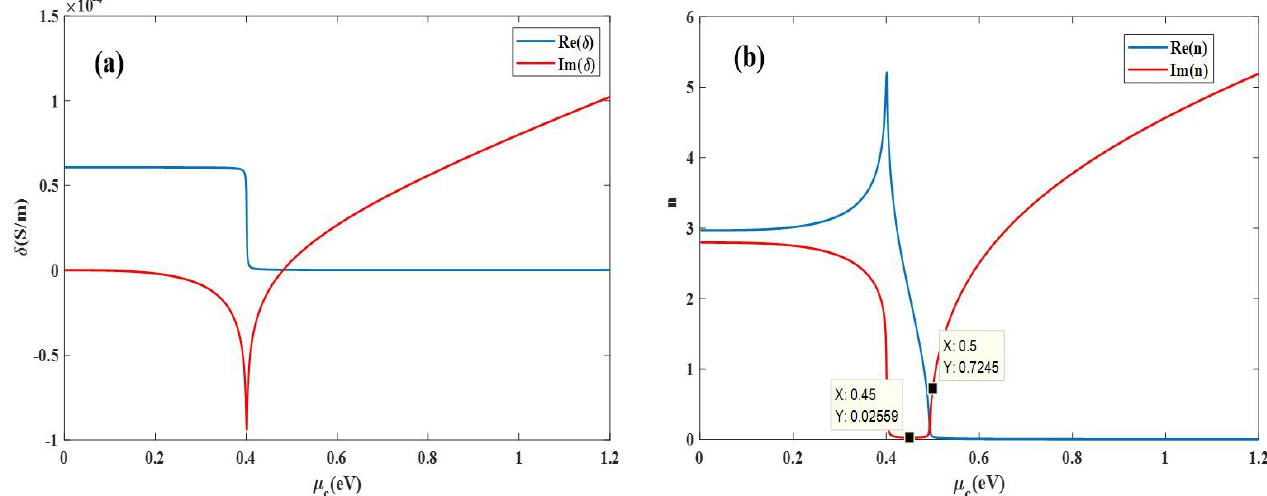
Figure 2. The graph of the electrical conductivity and equivalent refractive index with the graphene chemical potential. ( a ) Conductivity. ( b ) Equivalent refractive index.